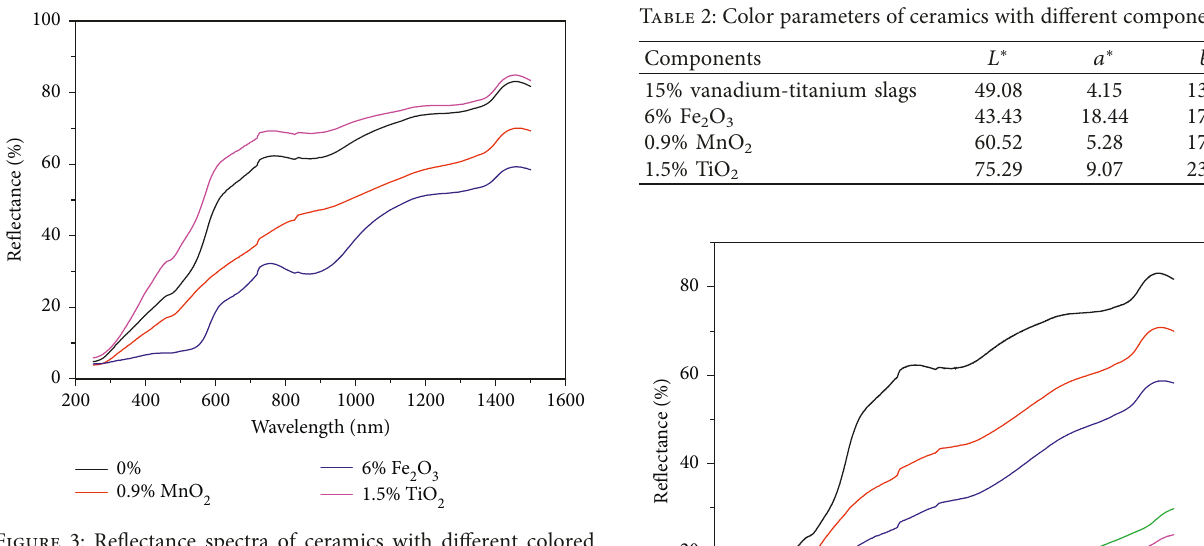
Figure 3: Reflectance spectra of ceramics with different colored oxides.